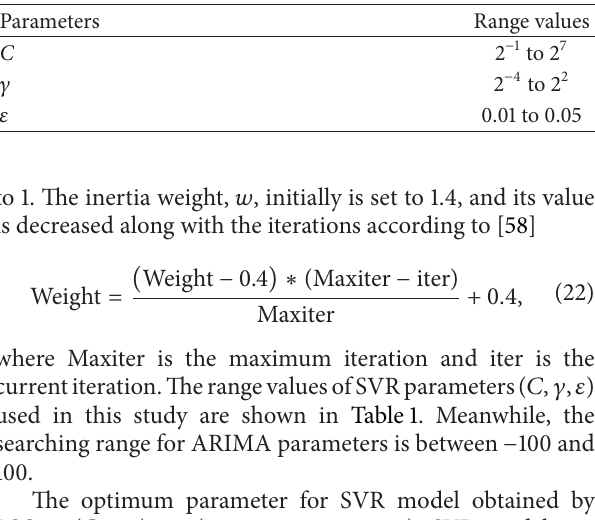
Table 1: The range values for the parameters ( 𝐶,𝛾, 𝜀